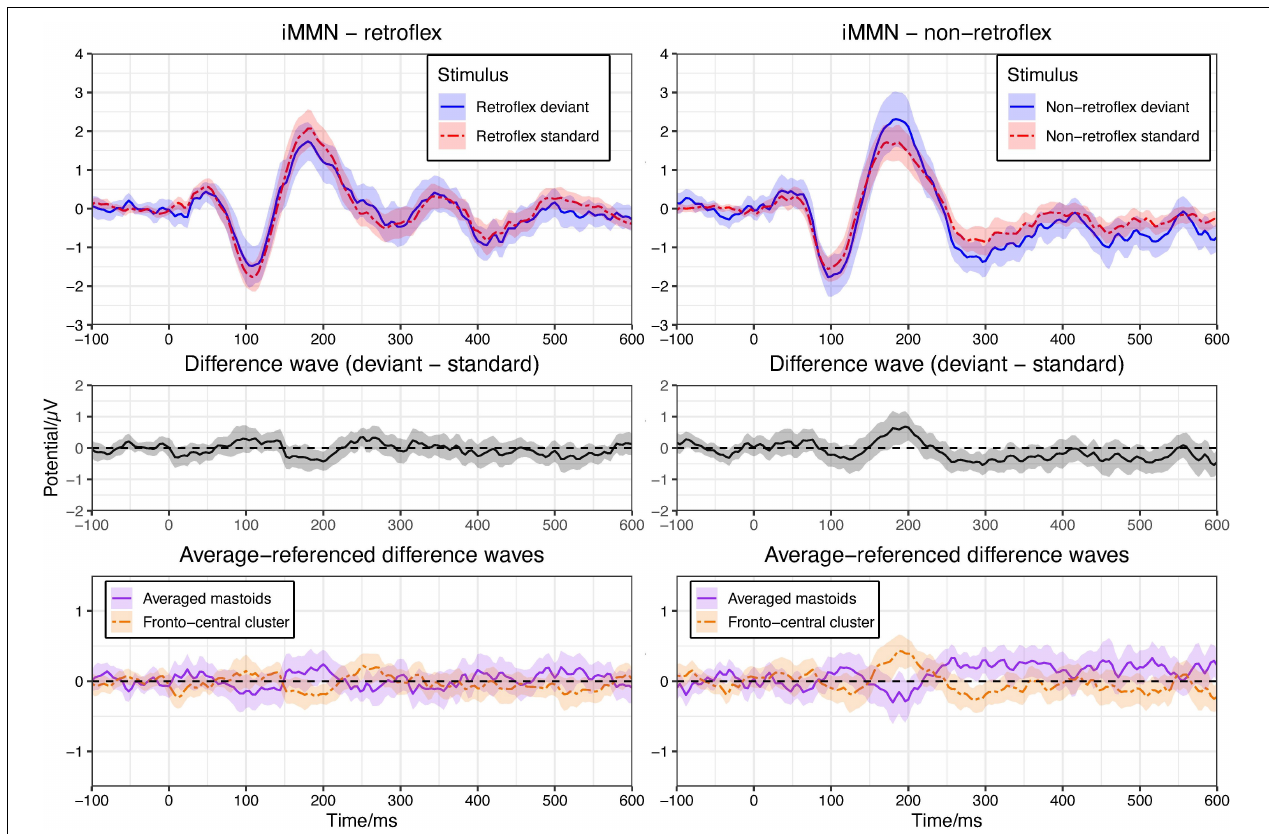
FIGURE 3 | Upper panel: means of grand average ERPs at electrodes Cz, Fz, FC1/2. Ribbons represent 95% confidence intervals. In both panels, there is no significant difference between the ERPs at any time point (pFDR < 0.05). Plots are arranged to show iMMNs. Left panel compares the ERPs to the retroflex standard and deviant; right panel compares the ERPs to the non-retroflex standard and deviant. Middle panel: difference waves of grand average ERPs at the fronto-central cluster (Cz, Fz, FC1/2). Lower panel: difference waves of grand average ERPs of averaged mastoids and the fronto-central cluster (Cz, Fz, FC1/2) with an average